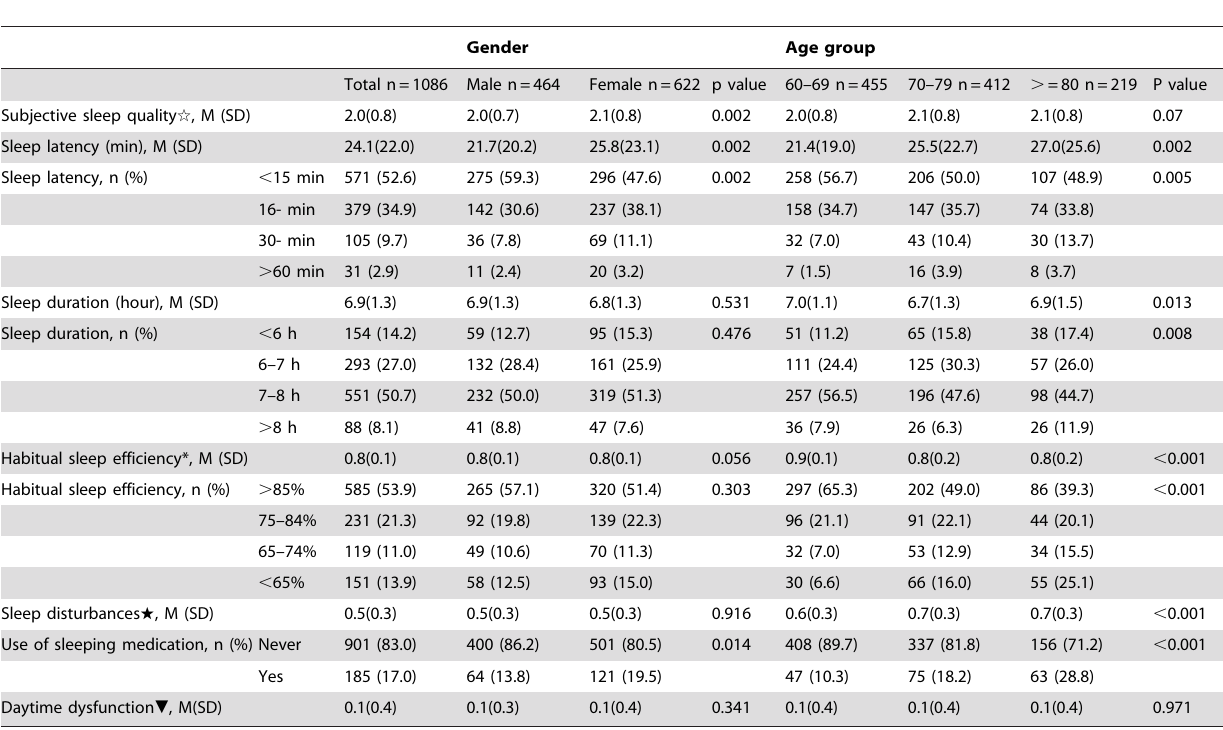
Table 2. Gender and age specific scores of sleep quality components measured by the Chinese version of the Pittsburgh Sleep Quality Index.